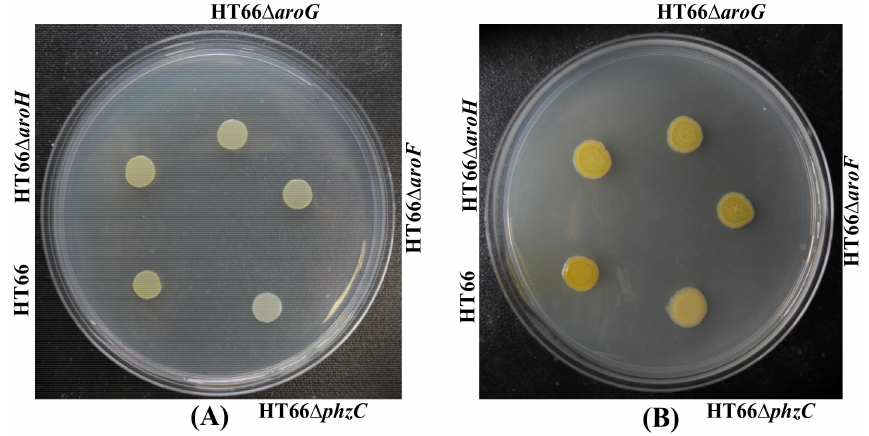
Figure 4. Photographs of the different derivatives grown on KB medium. ( A ) 24 h; ( B ) 48 h.